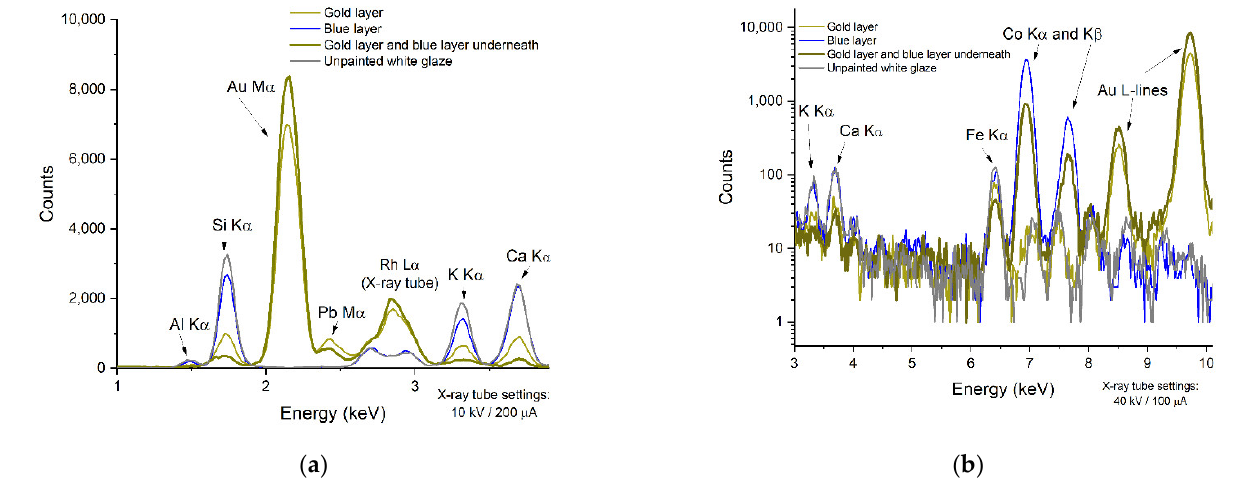
Figure 6. Two XRF spectra recorded at the 10 kV ( a ) and 40 kV ( b ) voltage settings at the central gilded area. Note the suppression of matrix peaks (Si, K, Ca) by the increasing thickness of golden/Sevres blue layers relative to the unpainted areas.